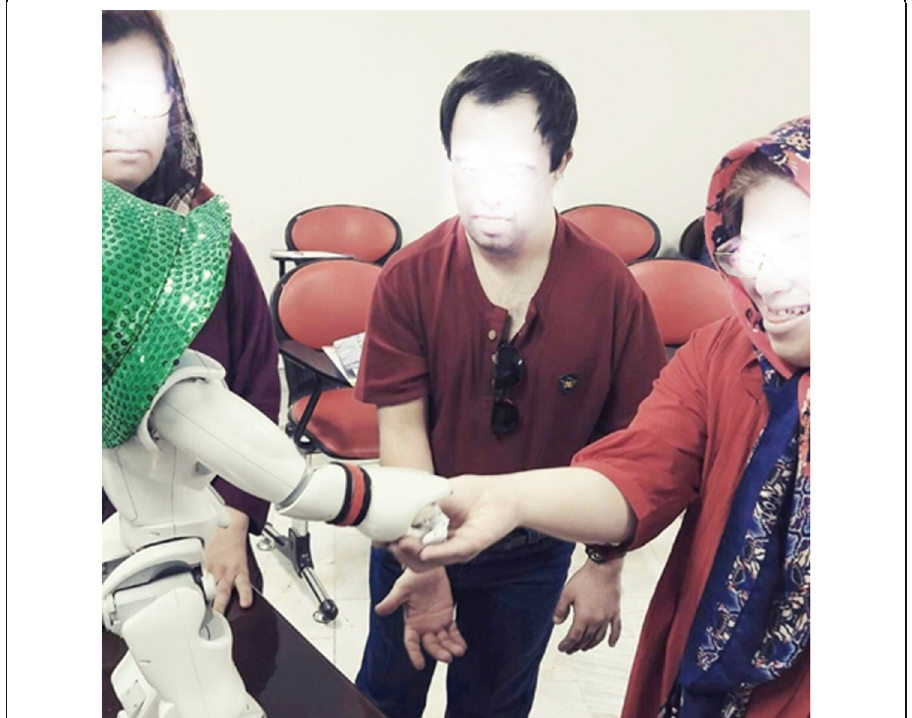
Fig. 8 Students shaking hands with